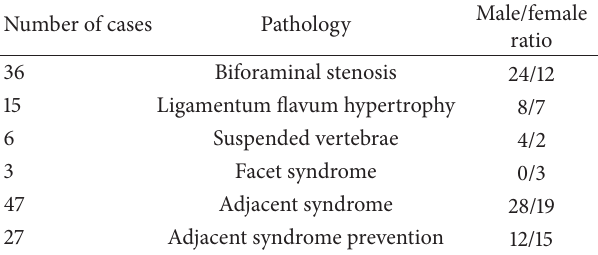
Table 1: Number of cases in correlation with disease and